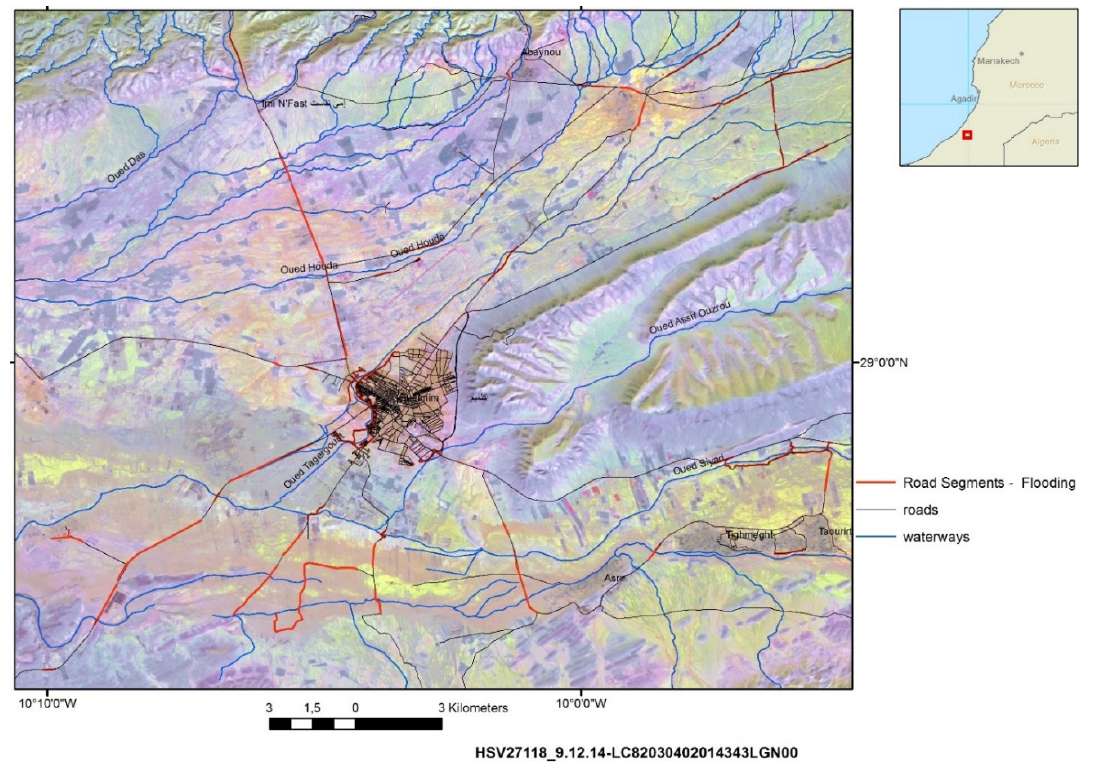
Figure 16. Roads intersecting waterways and flash flood areas (red